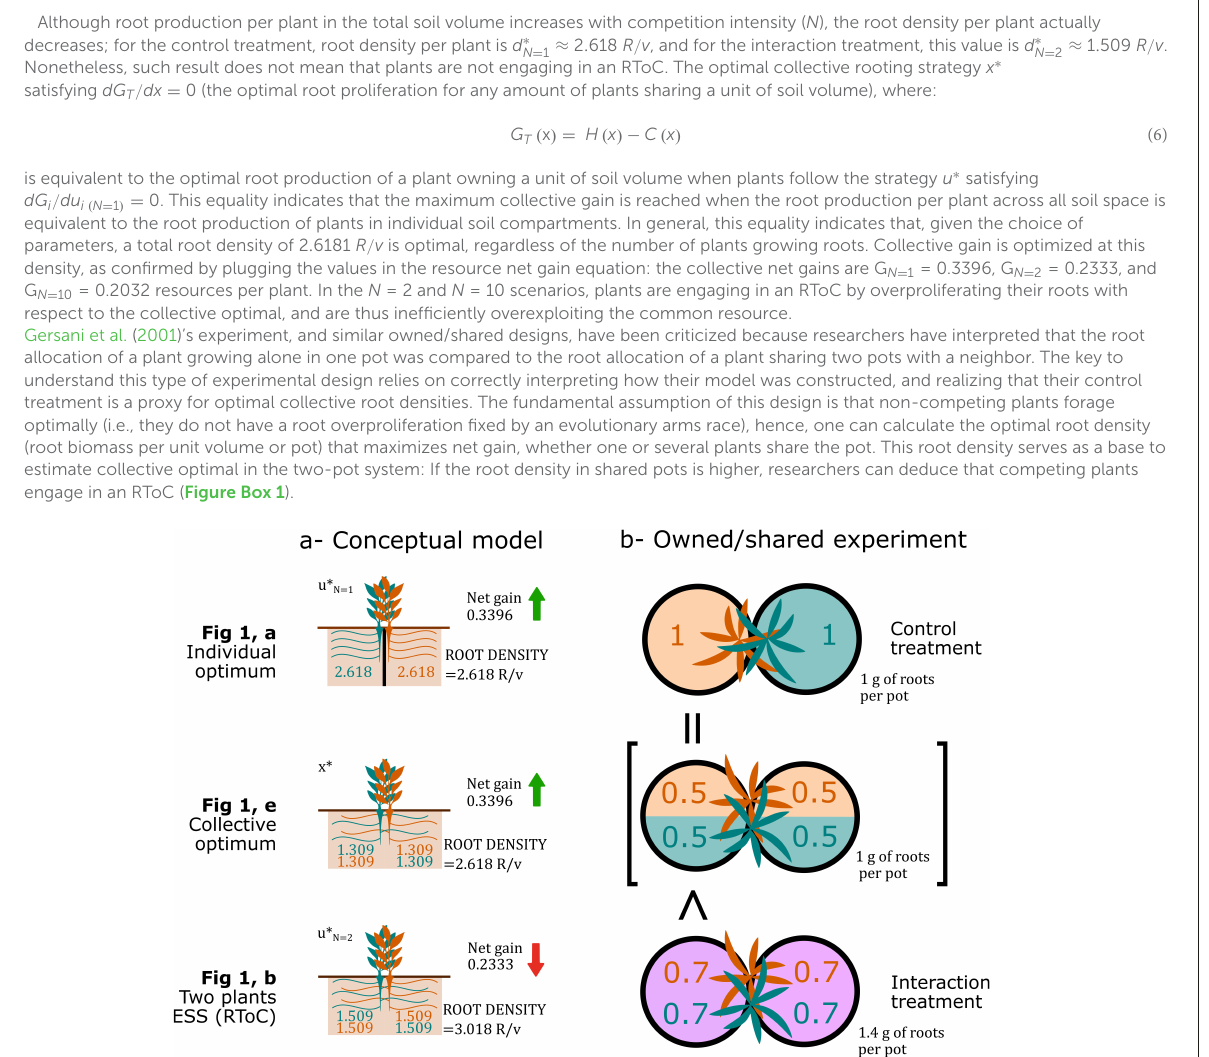
Figure Box 1: Results from Gersani et al. (2001), left, conceptual model (values based on the numerical results shown in Box) and, right, experimental results (approximated values from the original paper’s results) depicting how the individual optimal is analogous to the collective optimal of the two plants sharing two soil volumes in their